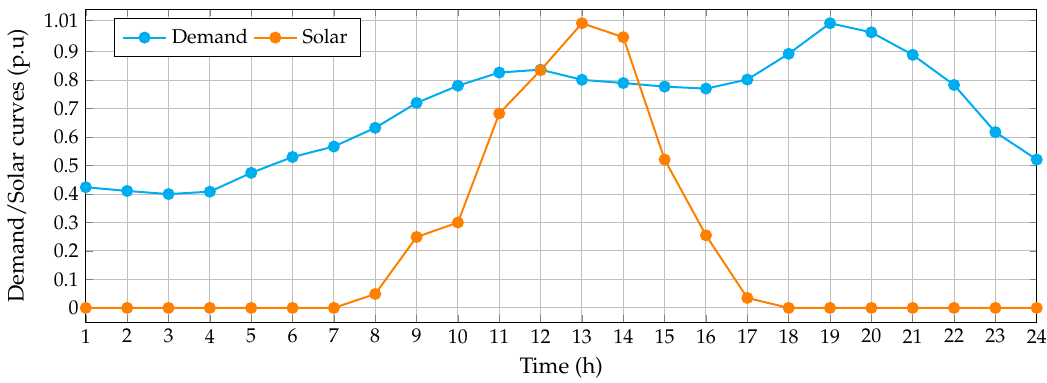
Figure 4. Solar generation and demand curves typical for the city of Medellín, Colombia.